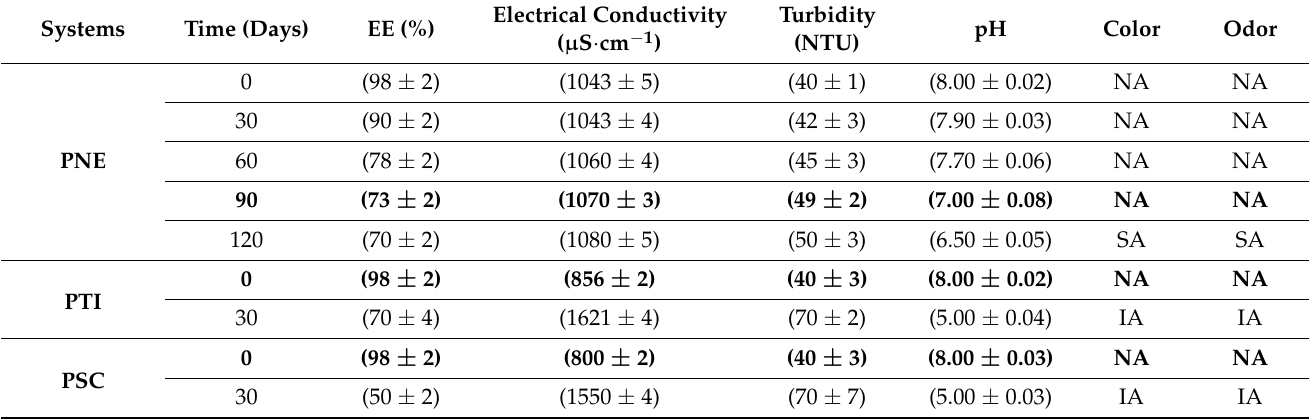
Table 4. Shelf-life stability of the PNE, PTI, and PSC systems at 35 ◦ C evaluated every 30